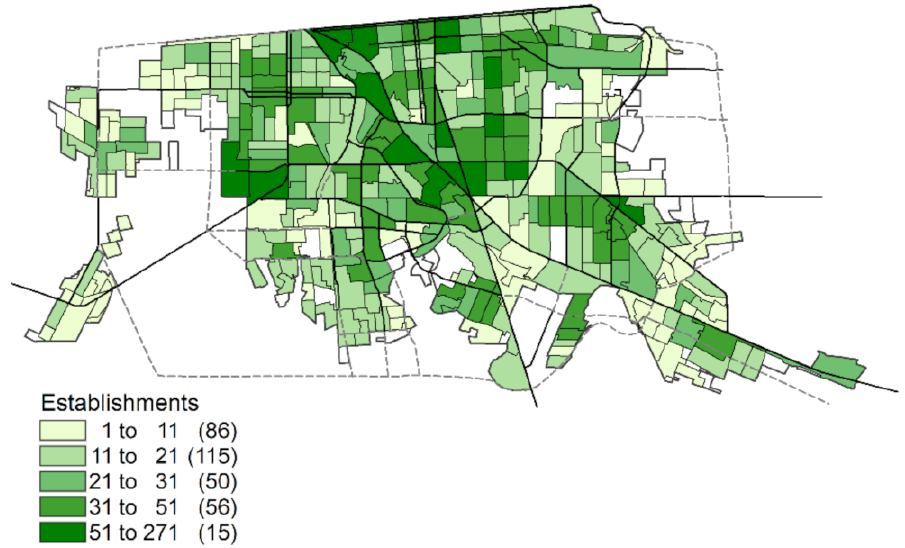
Figure 2. Distribution of commercial establishments in Mexicali, 2008